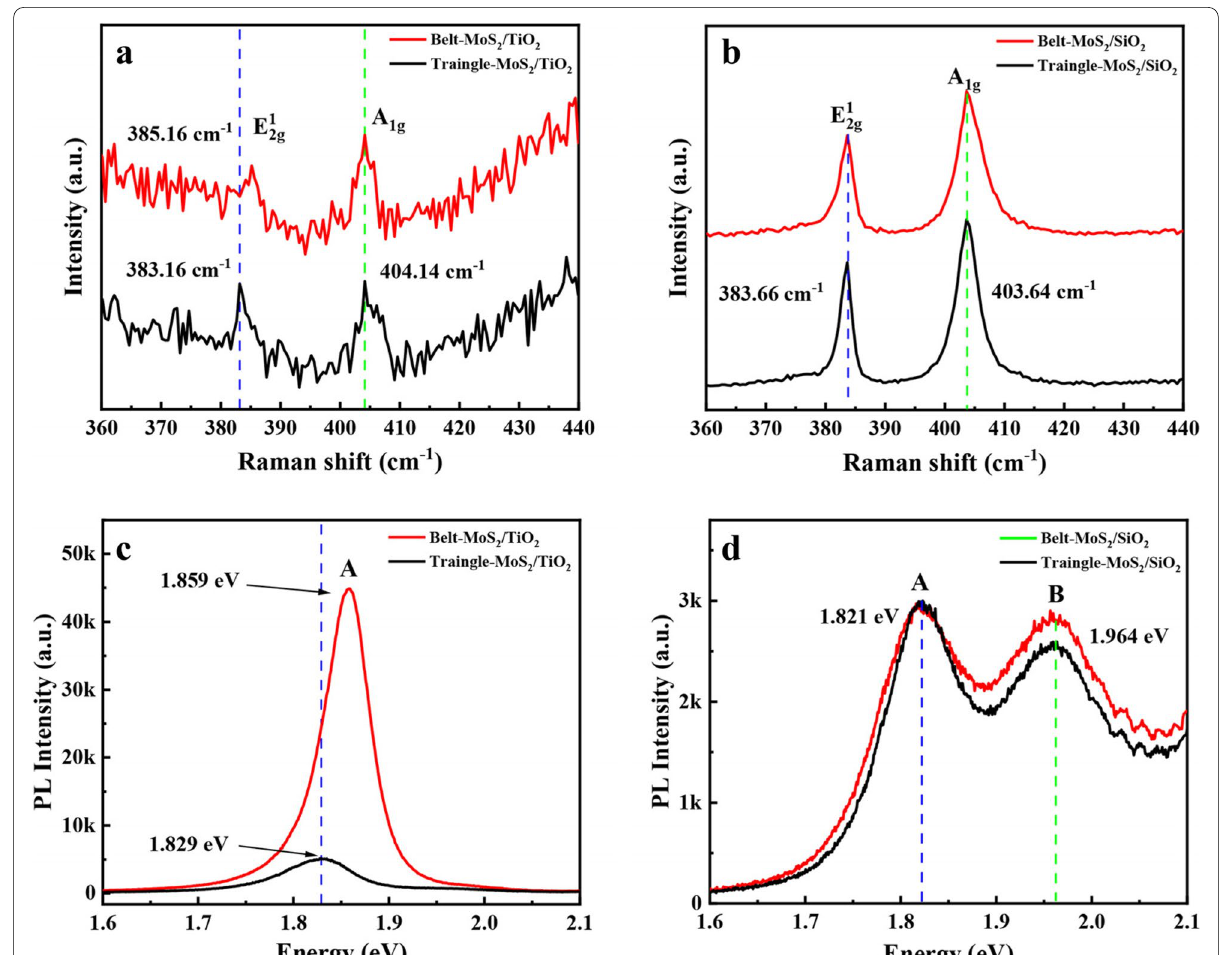
Fig. 4 a , b Raman spectra of ML MoS 2 belts (the red curve) and triangular ML MoS 2 structures (the black curve) on TiO 2 substrate and of those samples transferred onto a SiO 2 /Si substrate, respectively. c , d Photoluminescence (PL) spectra of as-prepared ML MoS 2 with the belt-like (the red curve) and triangular (the black curve) shape on TiO 2 substrate and on SiO 2 /Si surface,